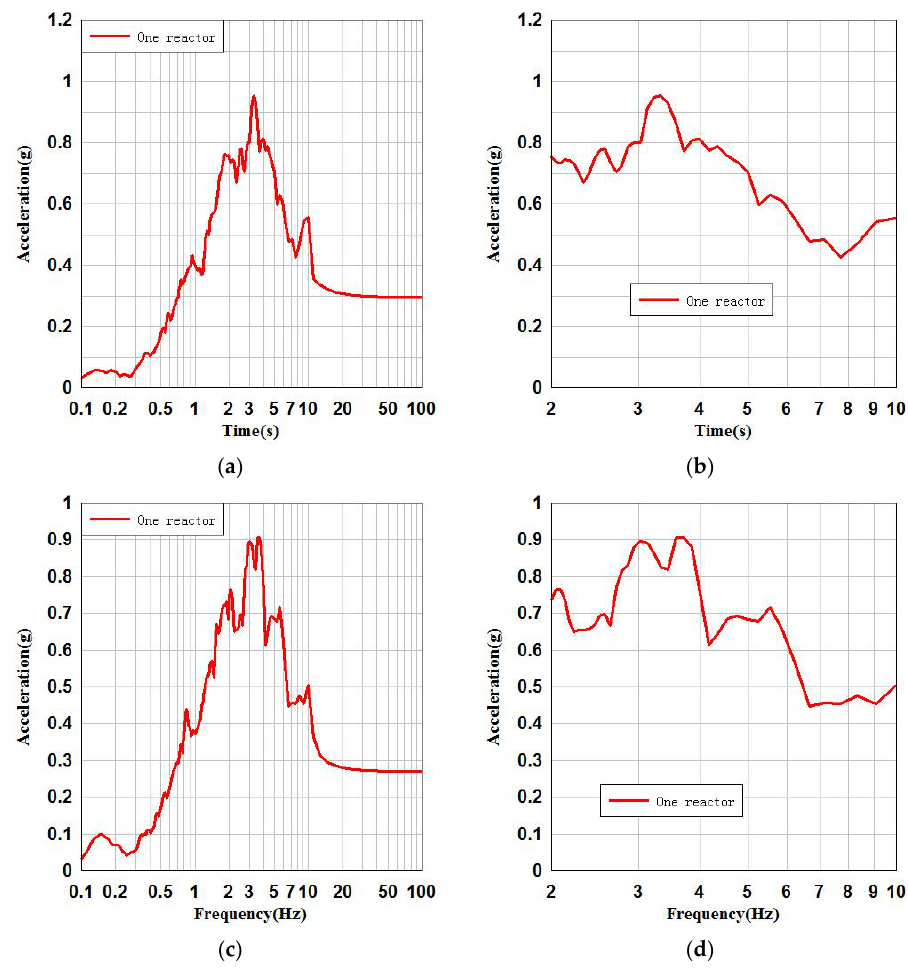
Figure 8. FRS of the key floor reference point in x and y directions. ( a ) FRS of the key floor in the x direction. ( b ) FRS of the key floor in the x direction (2–10 Hz). ( c ) FRS of the key floor in the y direction. ( d ) FRS of the key floor in the y direction (2–10